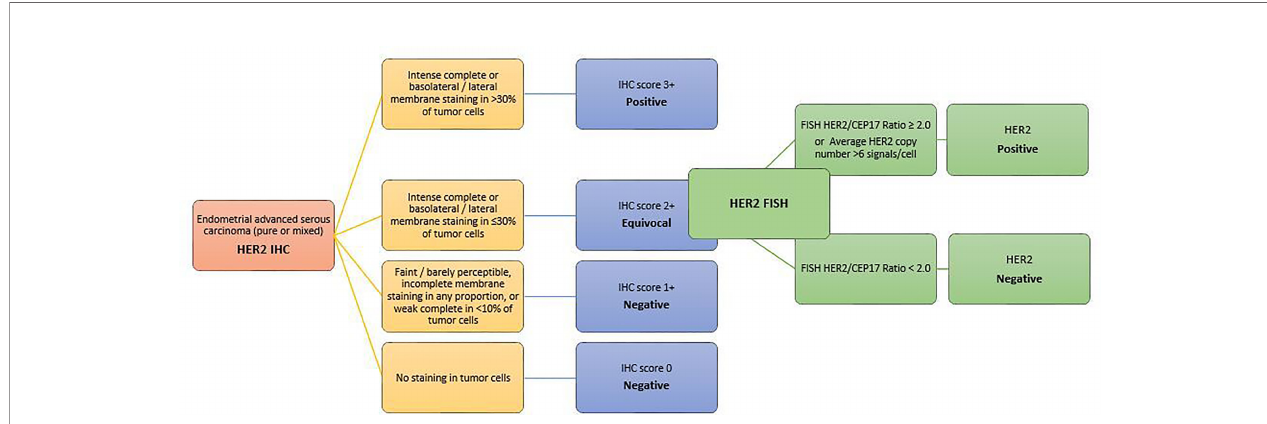
FIGURE 4 | HER2 scoring method in endometrial carcinomas A set of HER2 testing algorithm and scoring criteria have been proposed for routine pathological evaluation of endometrial serous carcinoma. Scoring categories have been classi fi ed according to the modi fi ed 2007 American Society of Clinical Oncology/College of American Pathologists [ASCO/CAP] breast